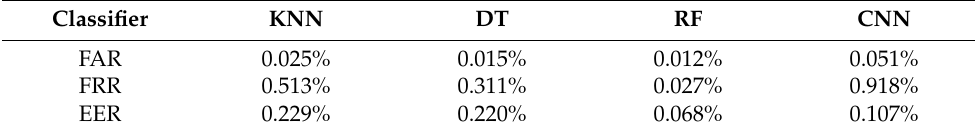
Table 10. CA evaluation—Scenario B: (a single point-and-click action): FAR, FRR, and EER.